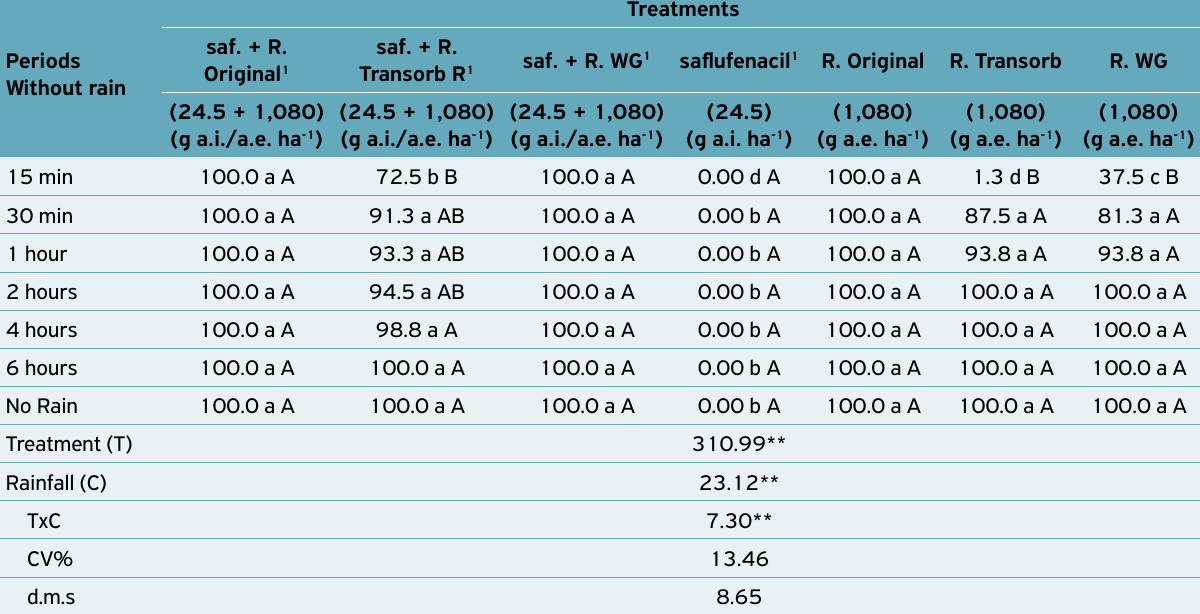
Means followed by the same lowercase letters in rows and uppercase in columns do not differ statistically by Tukey test (P < 0.05); 1 0.5% Dash added, DAA: Days After Application; R: Roundup; saf.: saflufenacil; **Significant at 1% probability